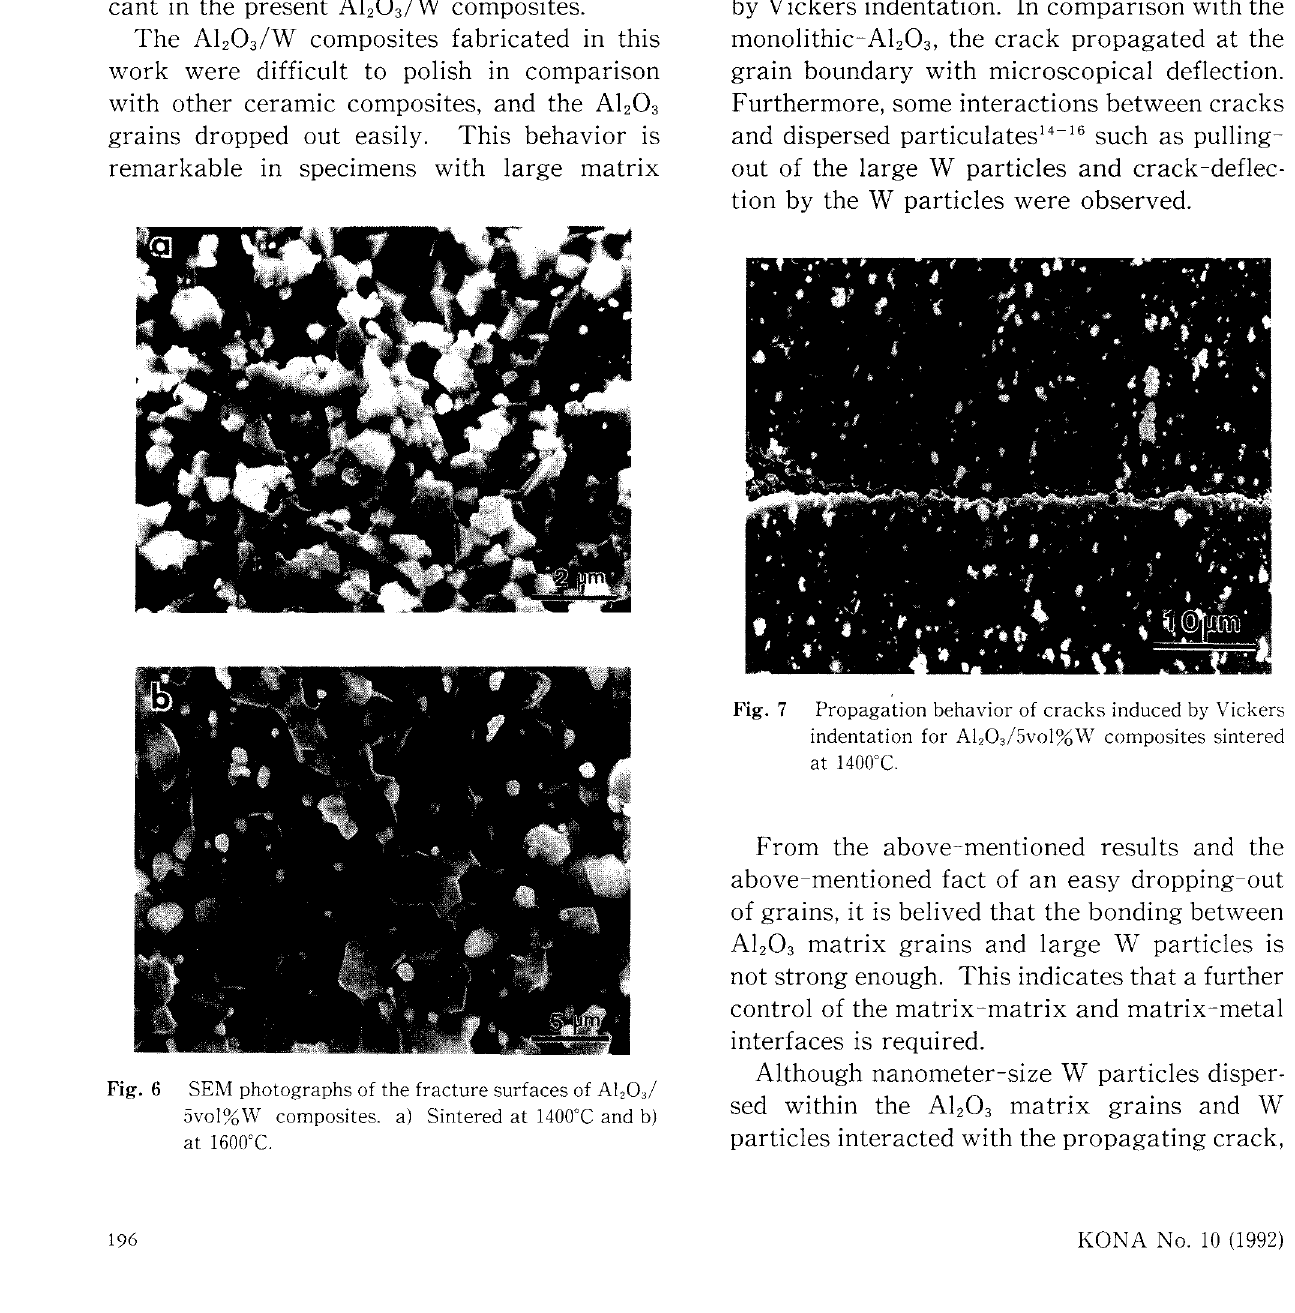
Fig. 6 SEM photographs of the fracture surfaces of Al 5vol%\'\' composites. a) Sintered at 1400T and b) at 1600T.